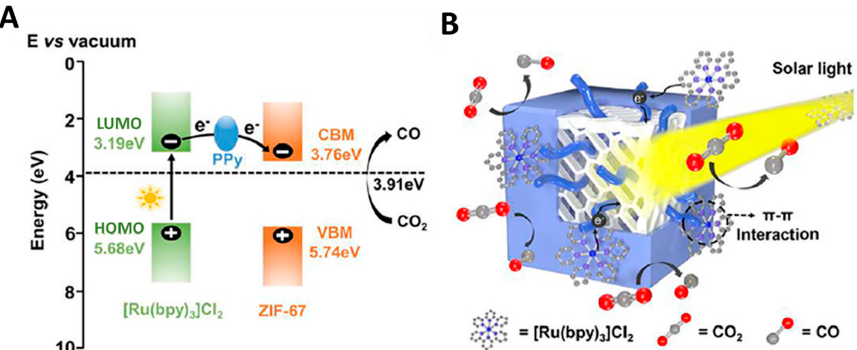
Figure 13. Scheme representing ( A ) the band levels and electron transfer among the [Ru(bpy) 3 ] 2+ photosensitizer, ZIF-67@PPy co-catalyst, and CO 2 /CO redox pair. On the right ( B ) the photocatalytic CO 2 reduction process on the cubic ZIF-67@PPy composite in the presence of [Ru(bpy) 3 ] 2+ (Reprinted with permission [160]. Copyright 2021 Elsevier).